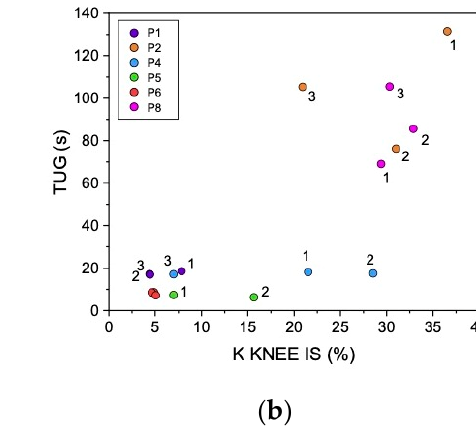
Figure 5. Knee stiffness at initial swing (K KNEE IS (%)) versus clinical assessments 10MWT ( a ) and